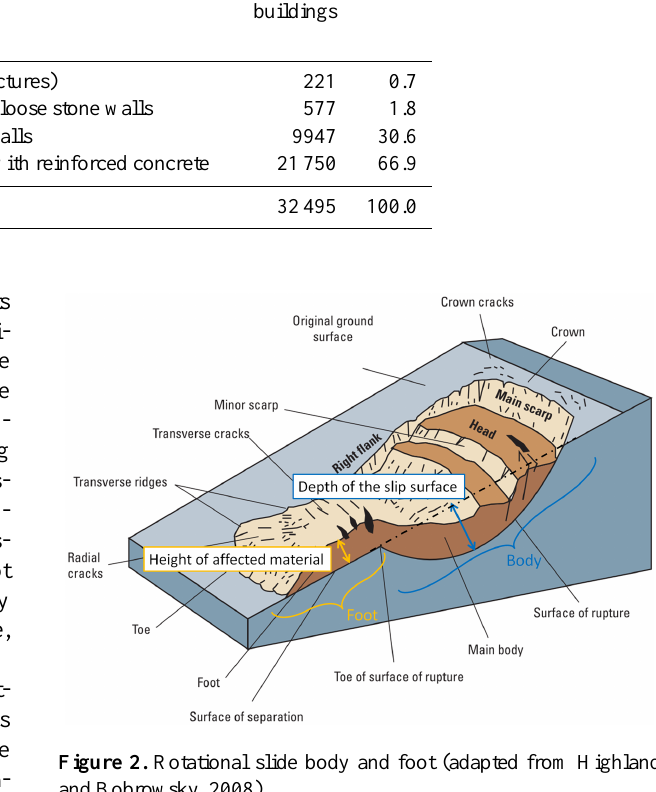
Table 1. Structural building types in the Loures municipality (National Institute of Statistics, Census 2011, INE, 2011). Structural Structural elements and construction